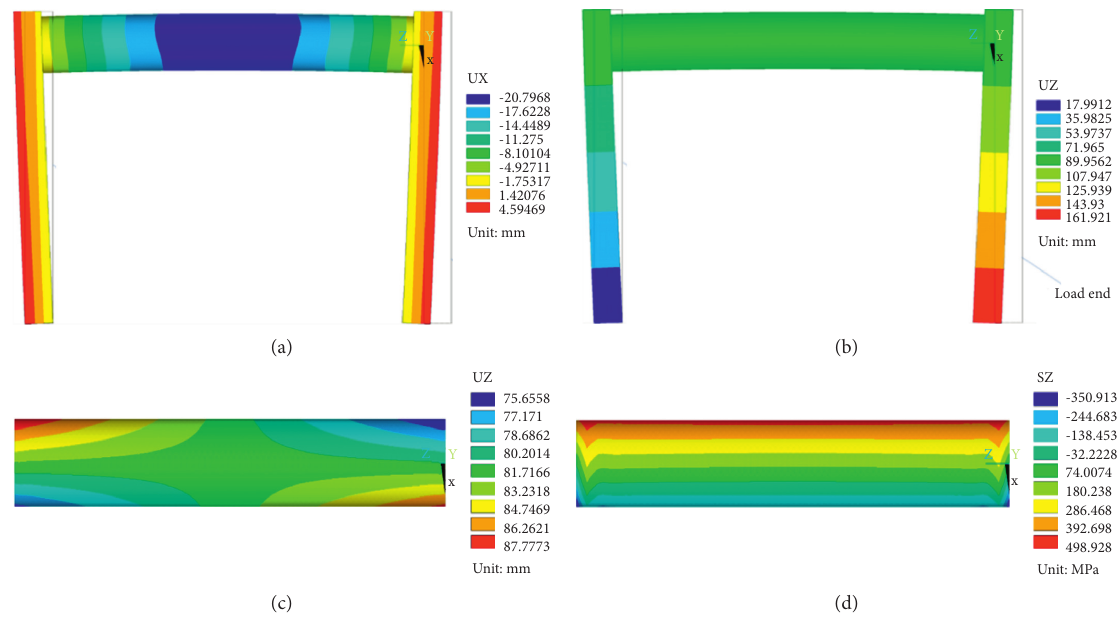
Figure 9: Distributions of overall displacement, pipe displacement, and pipe stress at 651s: (a) distribution of overall displacement in x direction; (b) distribution of overall displacement in z direction; (c) distribution of pipe displacement in z direction; (d) distribution of pipe axial stress in z direction.